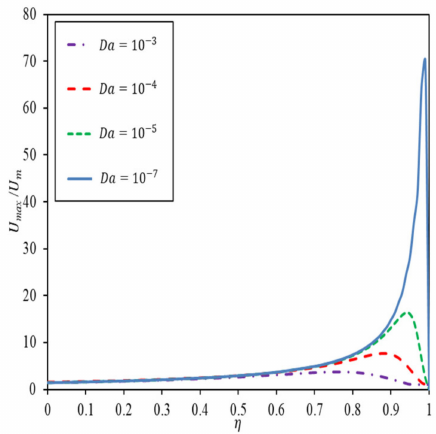
Figure 2. Maximum velocity achievable with porous medium thickness by having Da as a